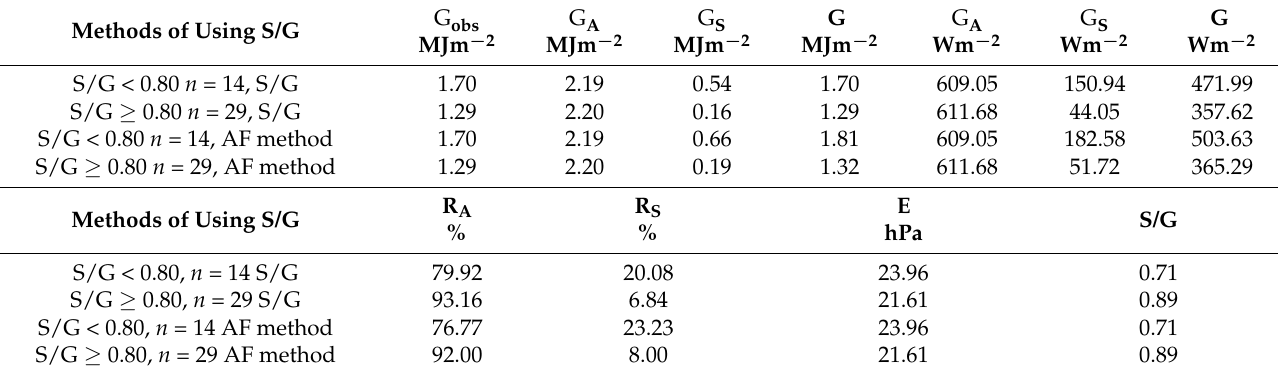
Table 6. Averages over all months in 3 years of global solar irradiance (MJ m − 2 ) and radiation (W m − 2 ) at the ground related to absorbing and scattering substances (G A and G S ), total (G = G A + G S + A 0 ), and their contributions to the total (R A = G A /(G A + G S ) and R S = G S /(G A + G S ), %), and calculated G A , G S , and G by using S/G calculated using the AF method and from observations, for conditions of S/G < 0.80 and S/G ≥ 0.80. Corresponding monthly values of observed global solar irradiance, water vapor pressure (E, hPa), and S/G are also shown. Methods of Using S/G